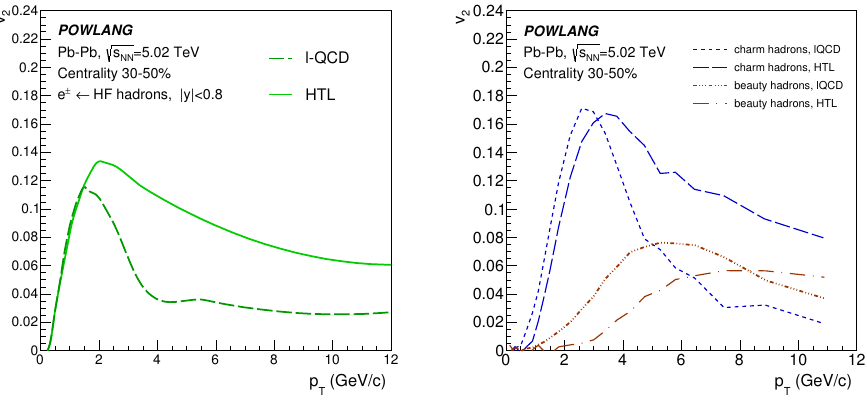
Figure 12 . The elliptic (cid:13)ow of electrons from semi-leptonic decays of heavy-(cid:13)avour hadrons in non- p central Pb-Pb collisions at s NN =5 : 02 TeV. POWLANG results with HTL and l-QCD transport coe(cid:14)cients are compared. In the right panel we display the corresponding results for the (cid:13)ow of the parent charm and beauty hadrons.